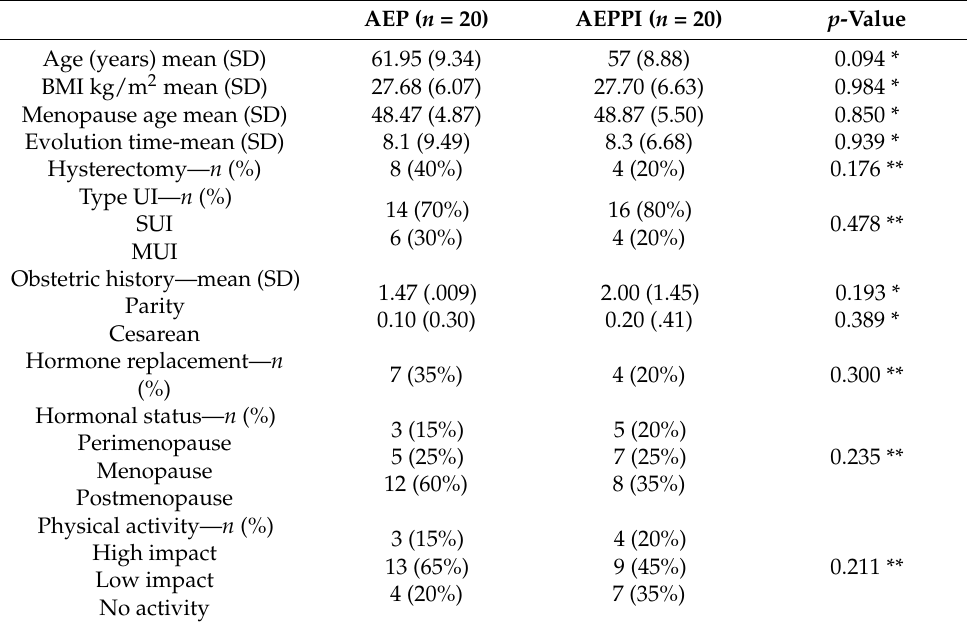
Table 1. General sociodemographic and clinical data ( n =